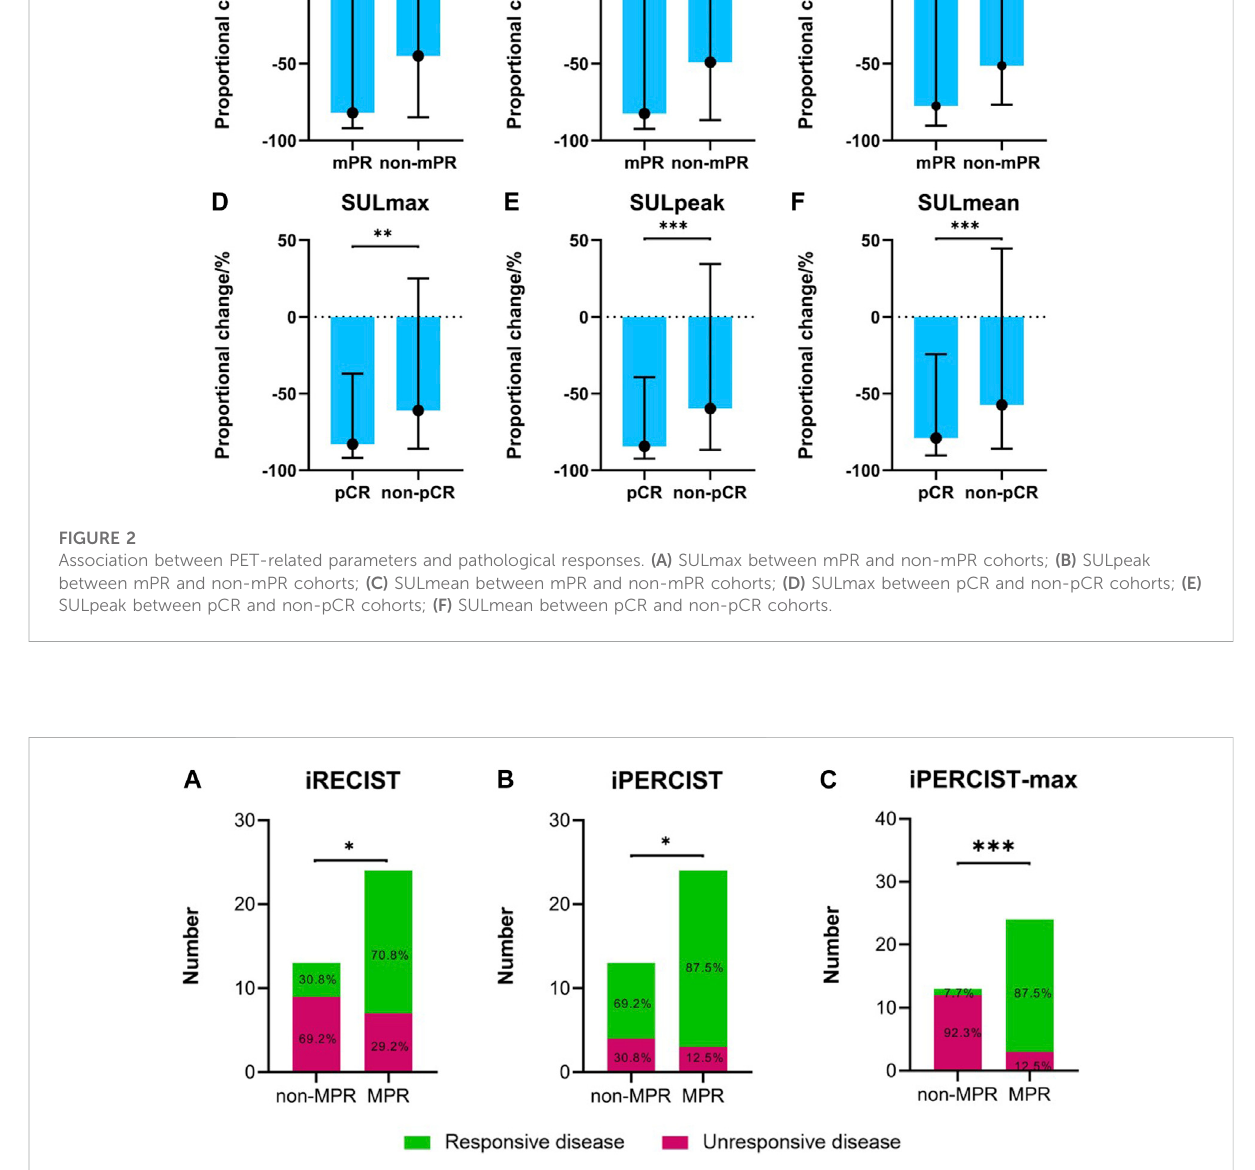
the fi ve iUPMD cases were iCPMD, and one patient presented with pseudoprogressive disease. Three of the fi ve iCMR patients underwent surgery, and all achieved pCR status. Despite the